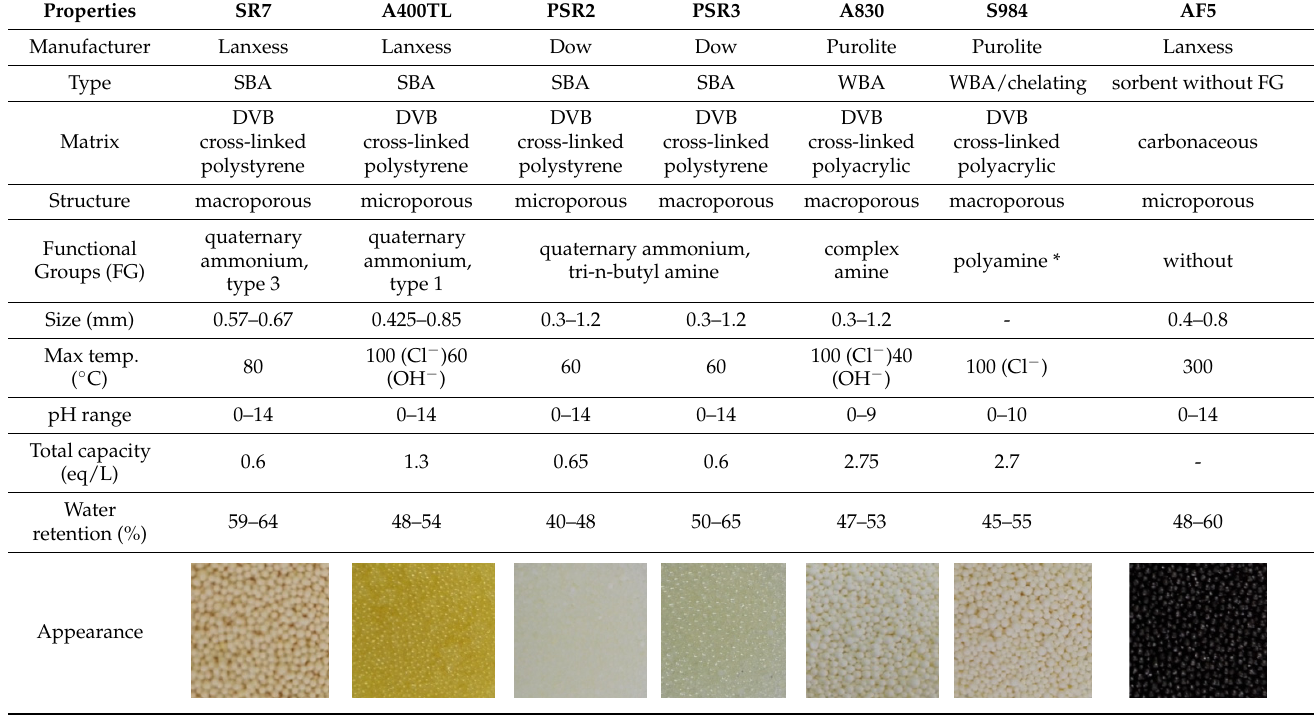
Table 1. Physicochemical properties of SR7, A400TL, PSR2, PSR3, A830, S984, and AF5 sorbents.